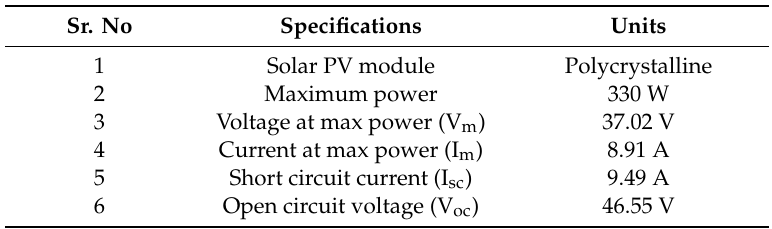
Figure 8. Schematic of the PV system with battery energy storage system and control device. Table 2. PV panel